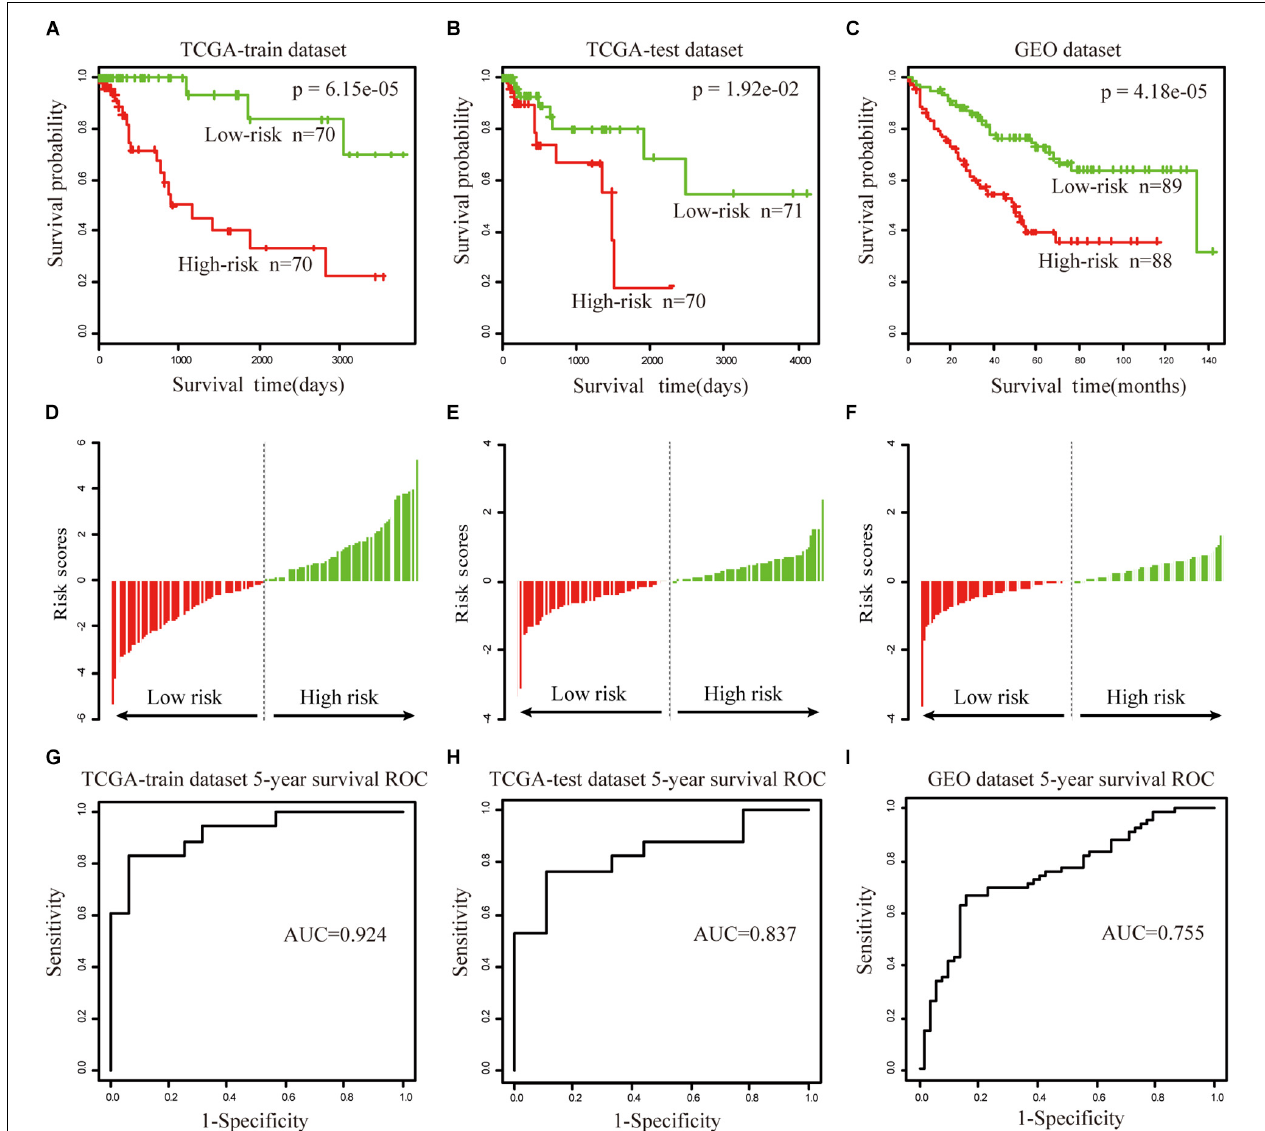
FIGURE 5 | The prognostic value of the nine genes signature in COAD. (A–C) Show the Kaplan–Meier survival curves for the train (A) , test (B) , and GEO datasets (C) . The red and green lines represent the high-risk and low-risk patients respectively. P -value means log rank P . (D–F) Show the detailed risk score distribution of patients in the train (D) , test (E) , and GEO datasets (F) . (G–I) Show the ROC curves and AUCs of the nine gene signature predicting patients’ five-year survival in the train (G) , test (H) , and GEO datasets (I)